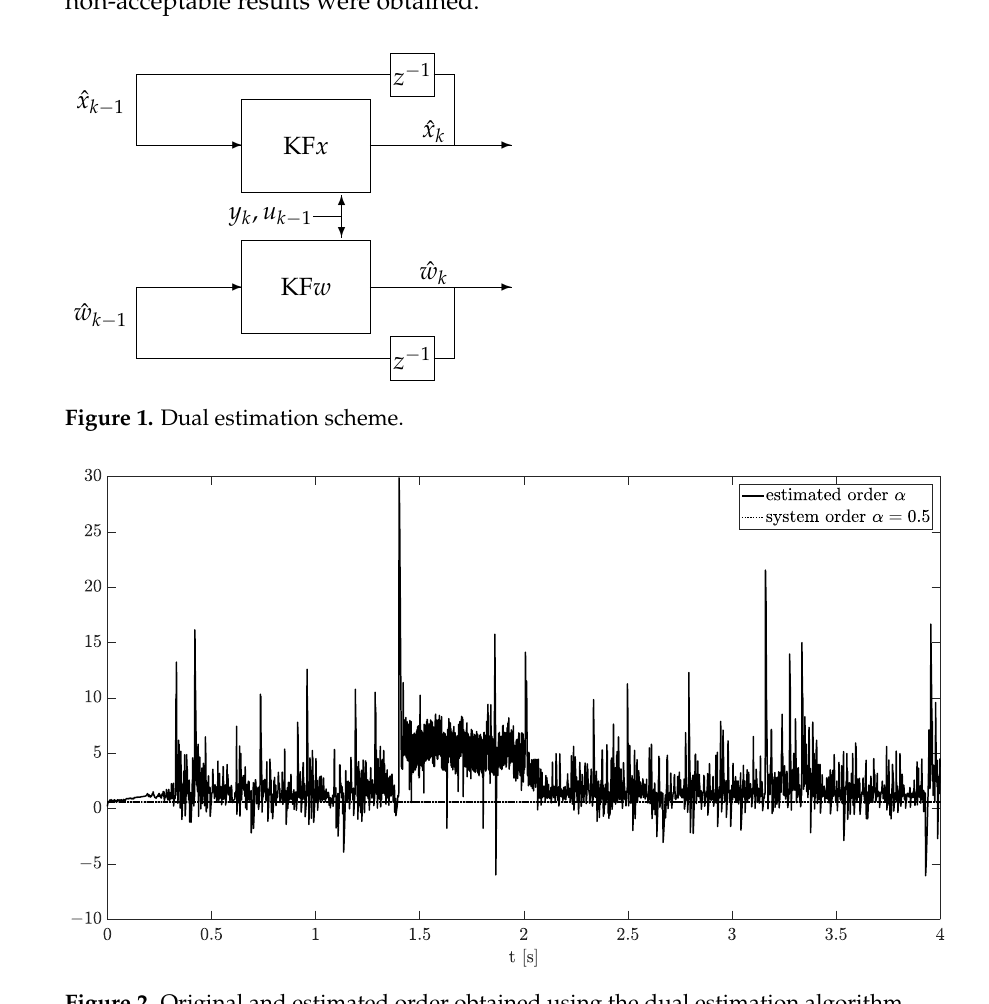
Figure 2. Original and estimated order obtained using the dual estimation algorithm.